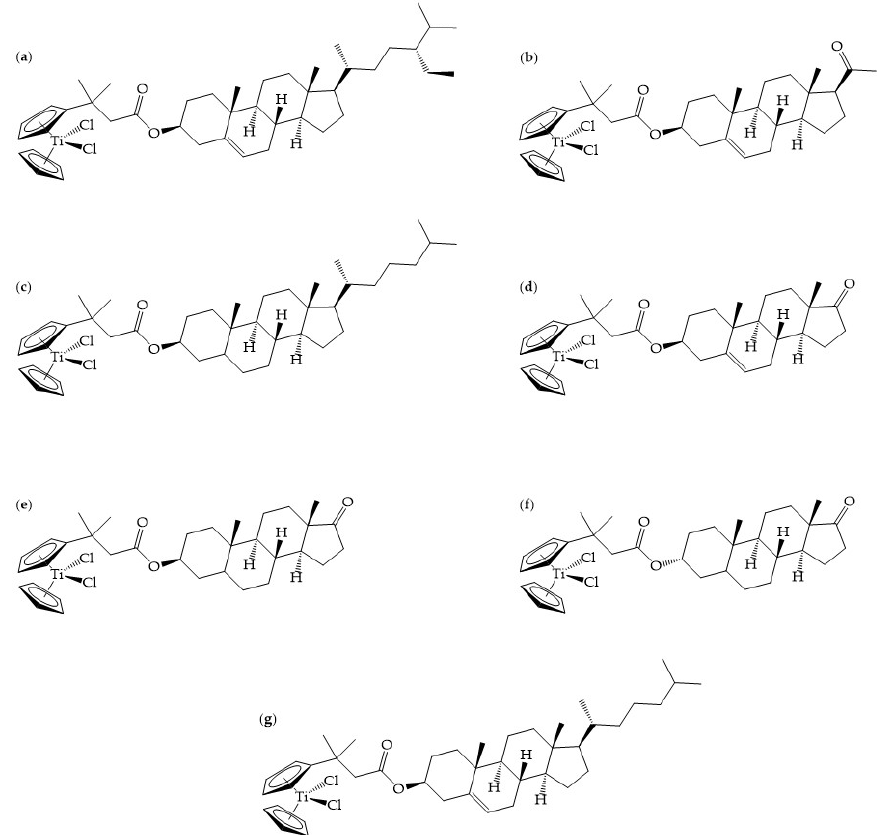
Figure 7. The chemical structures for titanocenyl clionasterol ( a ), pregnenolone ( b ), dihydrocholesterol ( c ), dehydroepiandrosterone ( d ), epiandrosterone ( e ), androsterone ( f ), and cholesterol ( g ) [67].